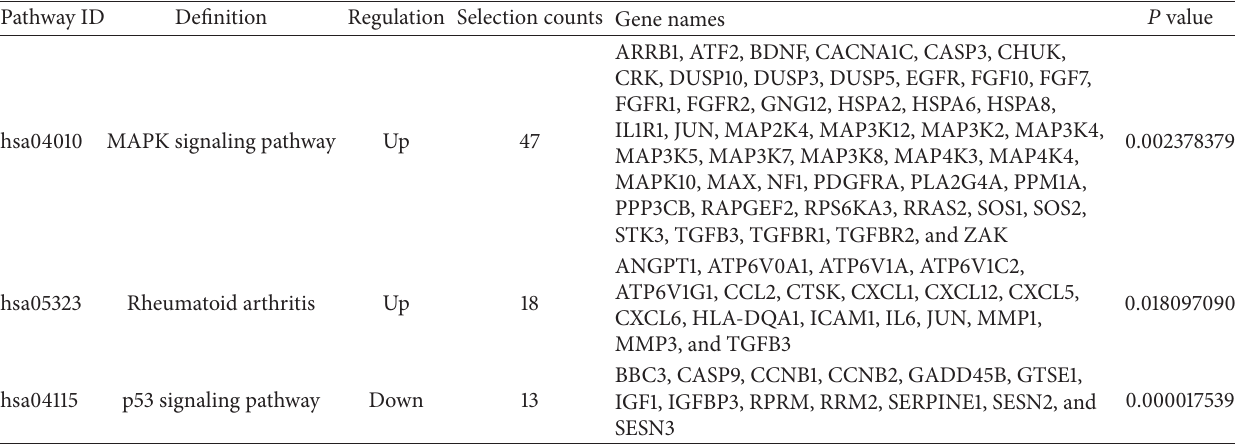
Table 6: KEGG pathway analysis results for RA